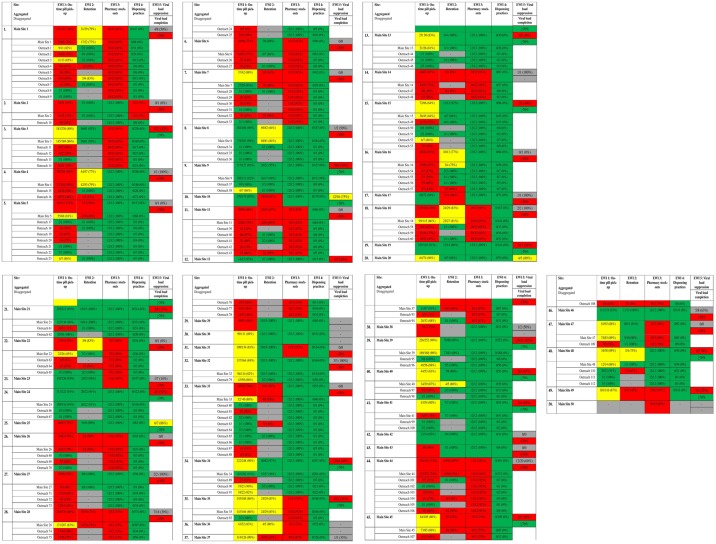
Pediatric Site-specific EWI Results.EWI—Early Warning Indicators Green indicates sites that achieved excellent performance, desired target level. Yellow indicates sites that achieved fair performance, progressing towards desired target level. Red indicates poor performance, below desired target. Gray indicates that data was not available from that site.